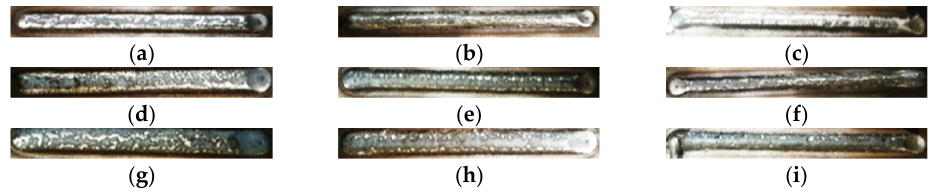
Figure 10. Weld passes obtained with different process parameters: ( a ) WS: 200 mm/min WFS: 4000 mm/min; ( b ) WS: 450 mm/min WFS: 4000 mm/min; ( c ) WS: 700 mm/min WFS: 4000 mm/min; ( d ) WS: 200 mm/min WFS: 6000 mm/min; ( e ) WS: 450 mm/min WFS: 6000 mm/min; ( f ) WS: 700 mm/min WFS: 6000 mm/min; ( g ) WS: 200 mm/min WFS: 8000 mm/min; ( h ) WS: 450 mm/min WFS: 8000 mm/min; ( i ) WS: 700 mm/min WFS: 8000 mm/min.